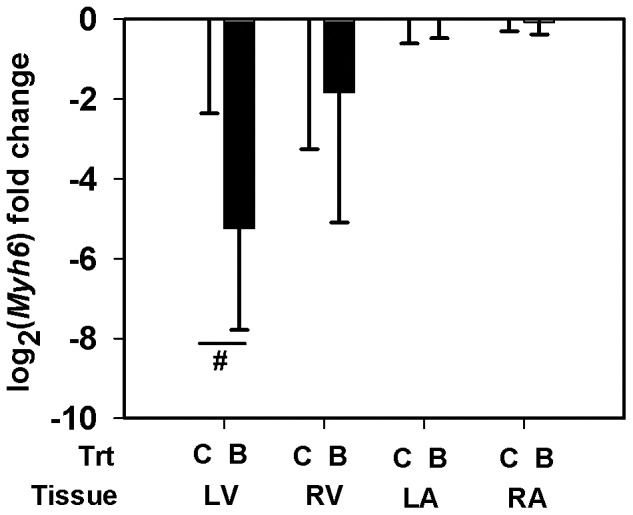
Altered fast myosin heavy chain expression.Real-time PCR quantification of myosin heavy chain 6, cardiac isoform alpha (Myh6) expression in the left ventricle (LV), right ventricle (RV), left atrium (LA) and the right atrium (RA) of rhesus monkey (Macaca mulatta) fetuses at birth. Fetuses were exposed maternally to a 400 µg/Kg. body weight of BPA dose (B) or 150 µL ethanol (C) during late gestation (LG, days 100±2–term). Data were analyzed by tissue and bars represent the mean ± S.E.M. of the log2 (fold change). A two sample t-test was performed to identify significant BPA effects and a two-tailed p≤0.05 was considered statistically significant. Marginal significance between the groups was indicated with a ‘#’ symbol.